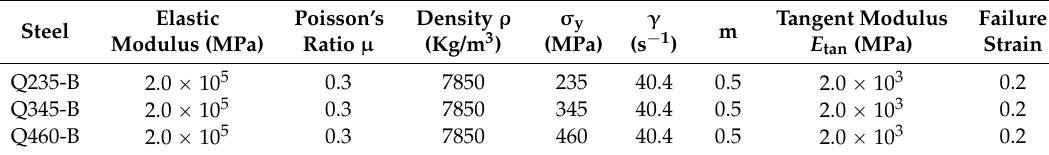
Table 3. Parameters of steel materials.